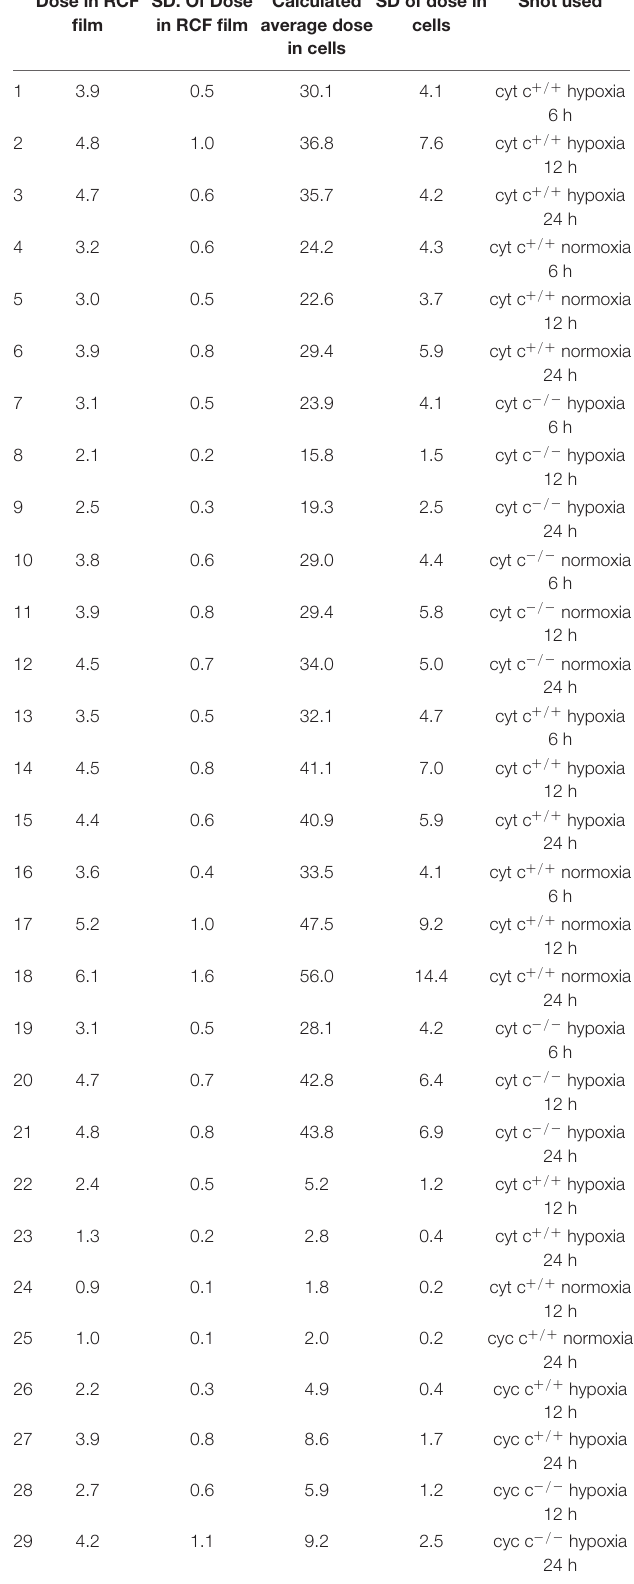
TABLE 1 | Summary of laser accelerator dose for each FLASH experiment. Dose in RCF